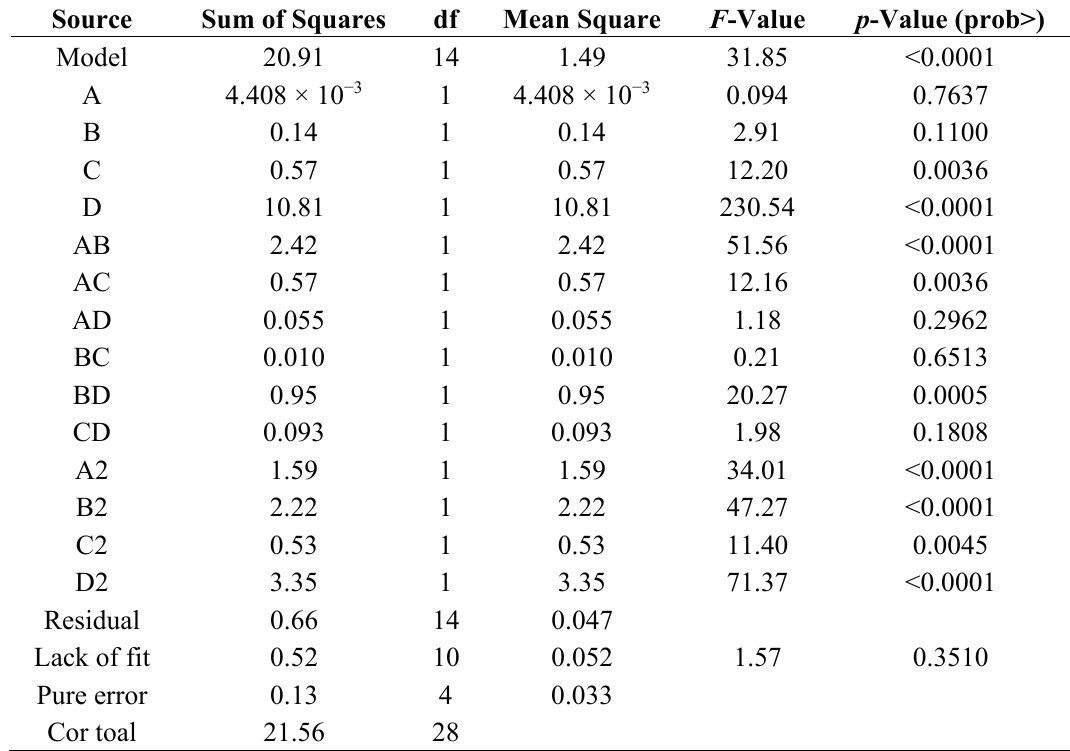
Table 3. ANOVA for Response Surface Quadratic